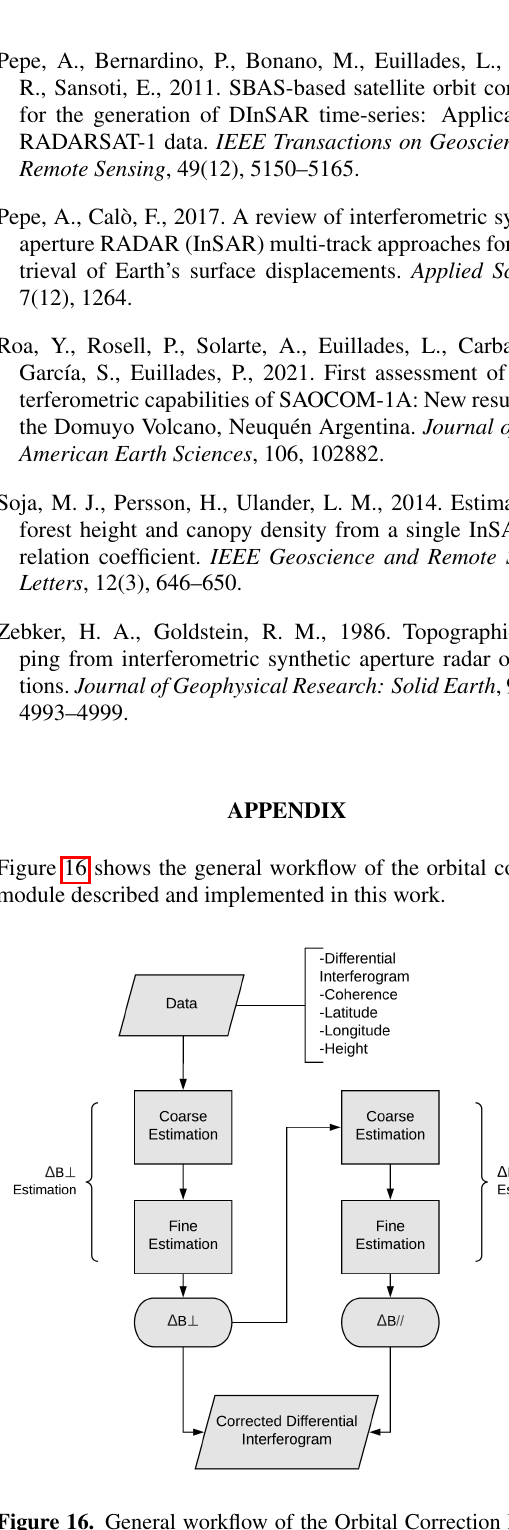
Figure 16. General workflow of the Orbital Correction Module implemented in Python language based on Pepe et al. (2011) ap-